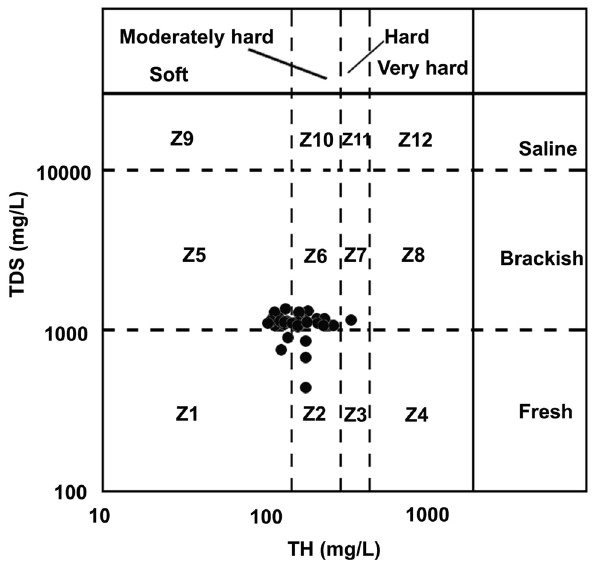
Fig. 4 Plot of TDS vs TH expressed in mg/l as CaCO